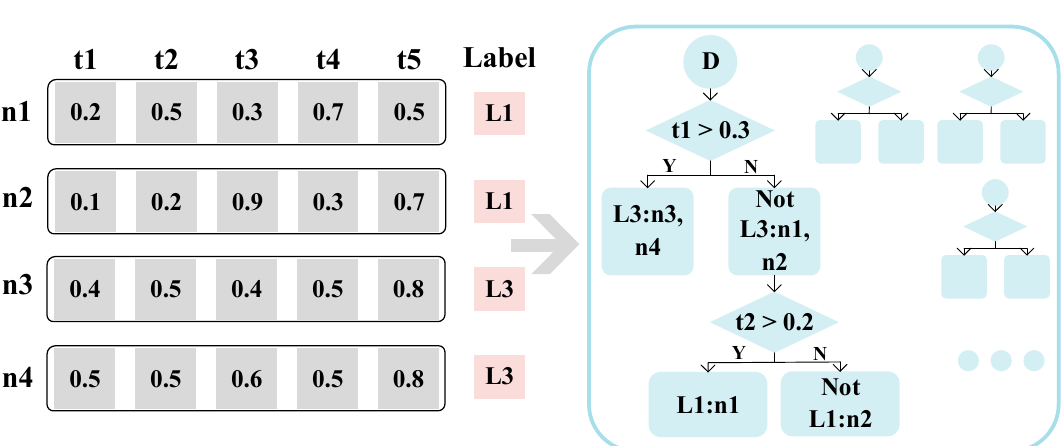
Figure 1. Decision Tree Generation Process.